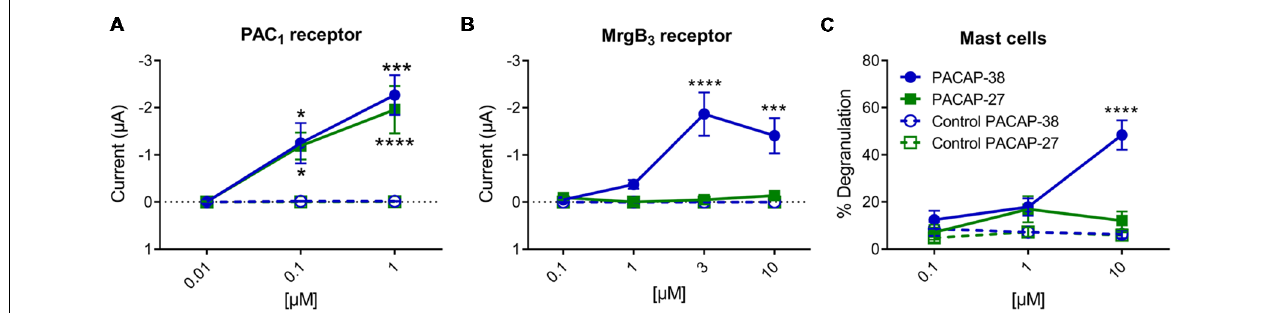
FIGURE 3 | (A) Two-electrode voltage clamp performed on Xenopus laevis oocytes expressing the PAC 1 -receptor ( n = 8–19, n control = 6–16) showed that increasing concentrations (0.01–10 µ M) of PACAP-38 and PACAP-27 cause a significant increase in membrane current. The inward currents are measured at a holding potential of − 70 mV. In (B) the Xenopus laevis oocytes is expressing the MrgB 3 -receptor ( n = 4–24, n control = 3–13). In these oocytes only PACAP-38 induces a significant change in current (Vm = − 70 mV). (C) Concentration-response curves of PACAP-38 and PACAP-27 on rat meningeal mast cell degranulation after 30 s stimulation at concentrations ranging from 0.1 to 10 µ M. It was found that a significant mast cell degranulation only was observed after stimulation with PACAP-38. Values are given as percentage of degranulated mast cells of total number of counted mast cells ( n = 5–6). ∗ Represent p < 0.05, ∗∗∗ p < 0.001, and ∗∗∗∗ p < 0.0001 [two-way analysis of variance (ANOVA), Sidak’s multiple comparisons test]. All values are given as mean ± standard error of the mean